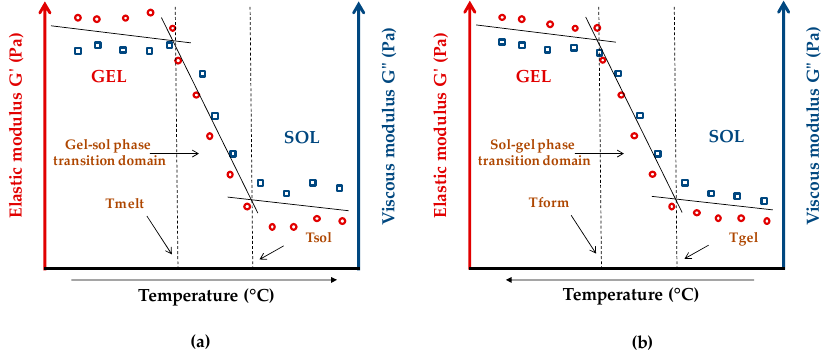
Figure 5. Schematic representation of phase transition parameters of an LMOG organogel: ( a ) organogel liquefaction process (temperature increase); ( b ) organogel formation process (temperature decrease).